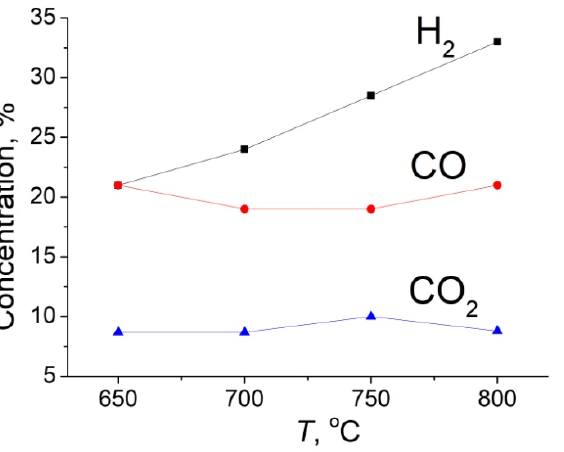
Figure 8. Temperature dependence of products concentration in the process of glycerol autothermal reforming on microchannel CrAlO substrate with supported (Ni + Ru)/MnCr 2 O 4 /10% MgO– γ -Al 2 O 3 active component. Feed 15% O 2 + 22% glycerol + 22% H 2 O + N 2 , contact time 0.06 s.